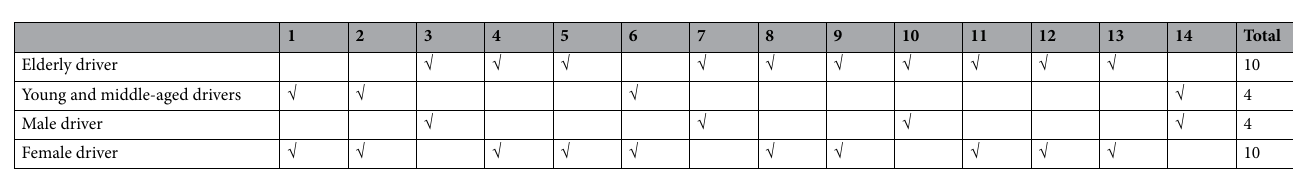
Table 5. Valuation results of the warning effect of the RTCRWS on different